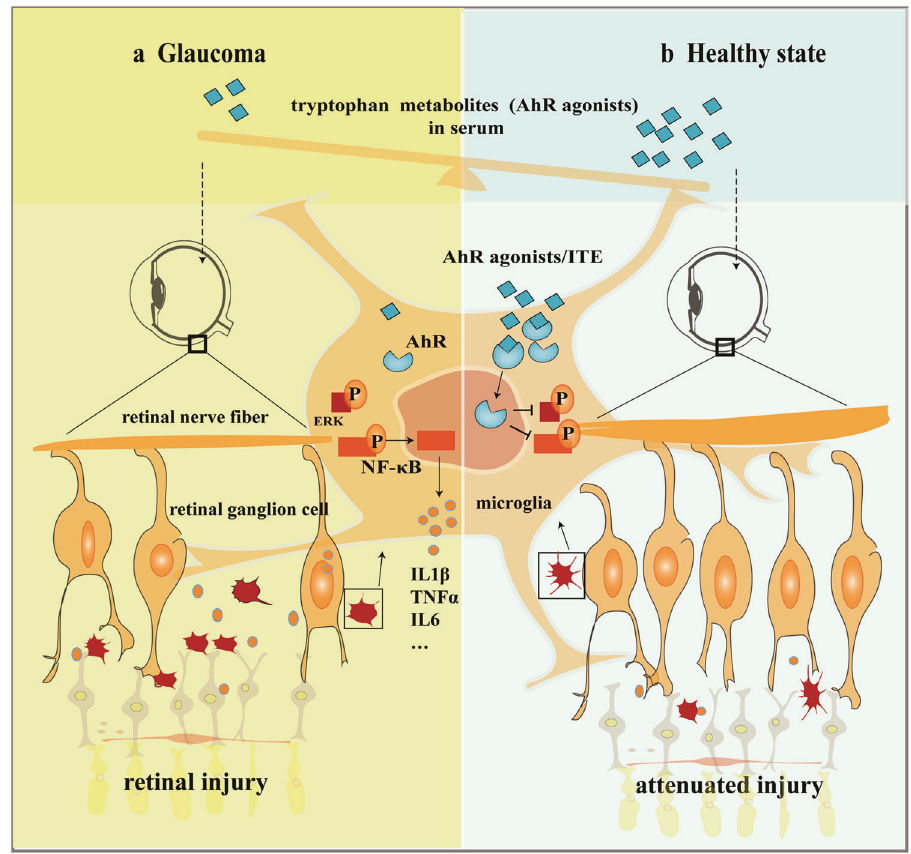
Fig. 8 AhR dependent anti-in fl ammation and neuroprotective effects of tryptophan metabolites on retinas under ocular hypertension. Disturbed serum tryptophan metabolism and reduced AhR agonists are shown in glaucoma state, which result in reduced microglial AhR activation. Ampli fi ed local in fl ammation mediated by microglia, which are ERK and NF κ B signaling dependent, could cause signi fi cant neurotoxicity to RGCs under ocular hypertension ( a , left). However, tryptophan metabolism is normal and there are enough AhR agonists in healthy state. Supplementation of tryptophan metabolites such as ITE could signi fi cantly inhibited ERK and NF κ B dependent local in fl ammation and attenuated retinal injury under ocular hypertension via AhR activation ( b , right). In summary, AhR activation by tryptophan metabolites play anti-in fl ammation and neuroprotective roles in